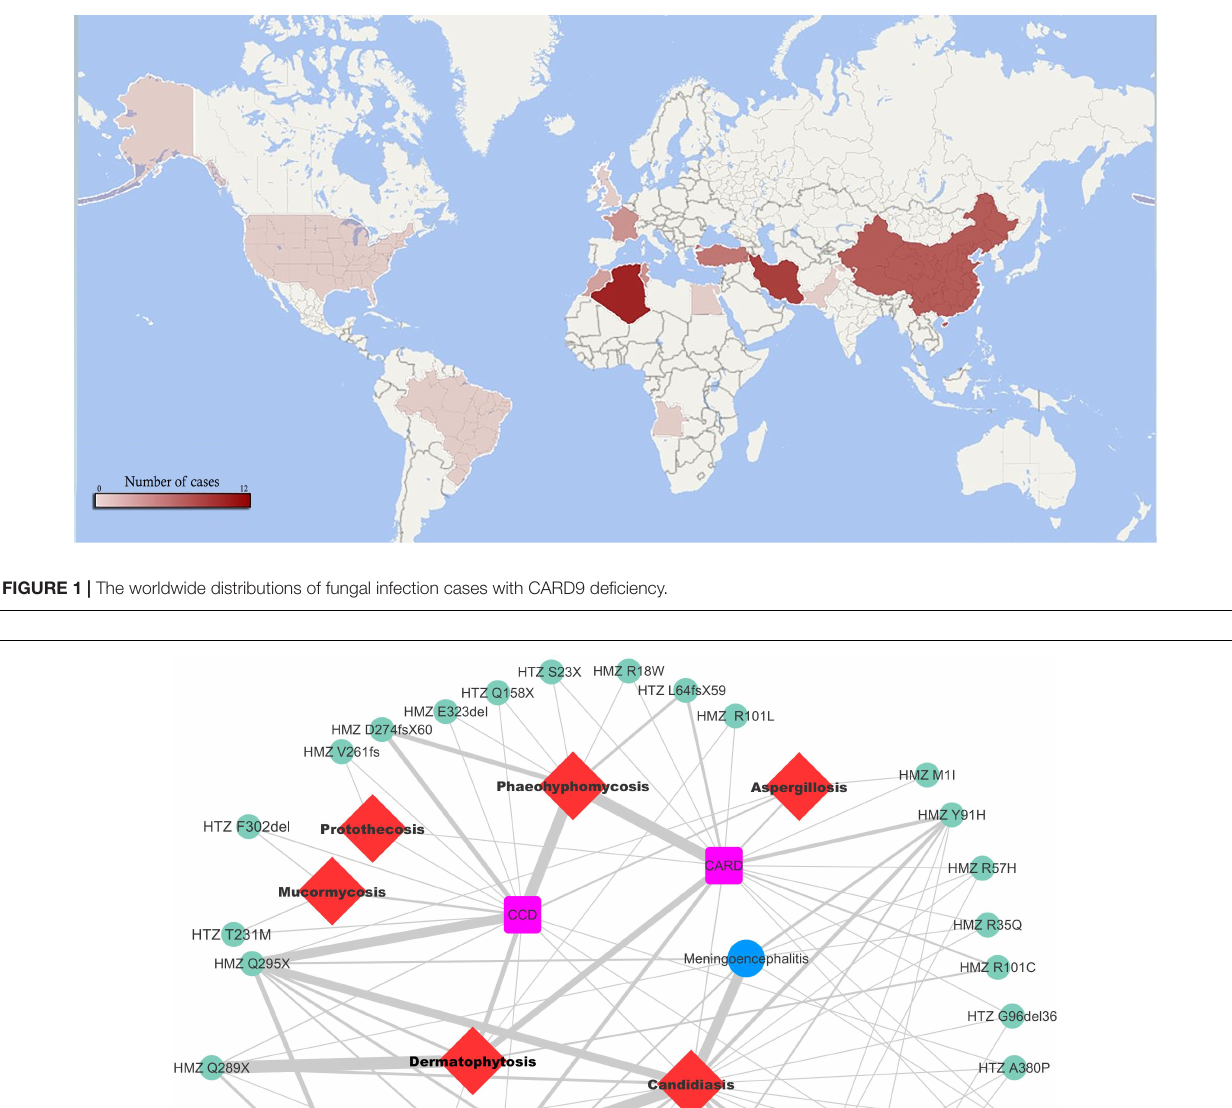
and disseminated phaeohyphomycosis; 2.42 (95% CI 1.84–3.2, p < 0.001). This study demonstrated that the HMZ p.Q289X (c.865C > T) mutation had a more than two-fold increased risk of dermatophytosis compared with HMZ p.Q295X (c.883C > T), p < 0.001. Similarly, HMZ p.Q295X (c.883C > T) alteration